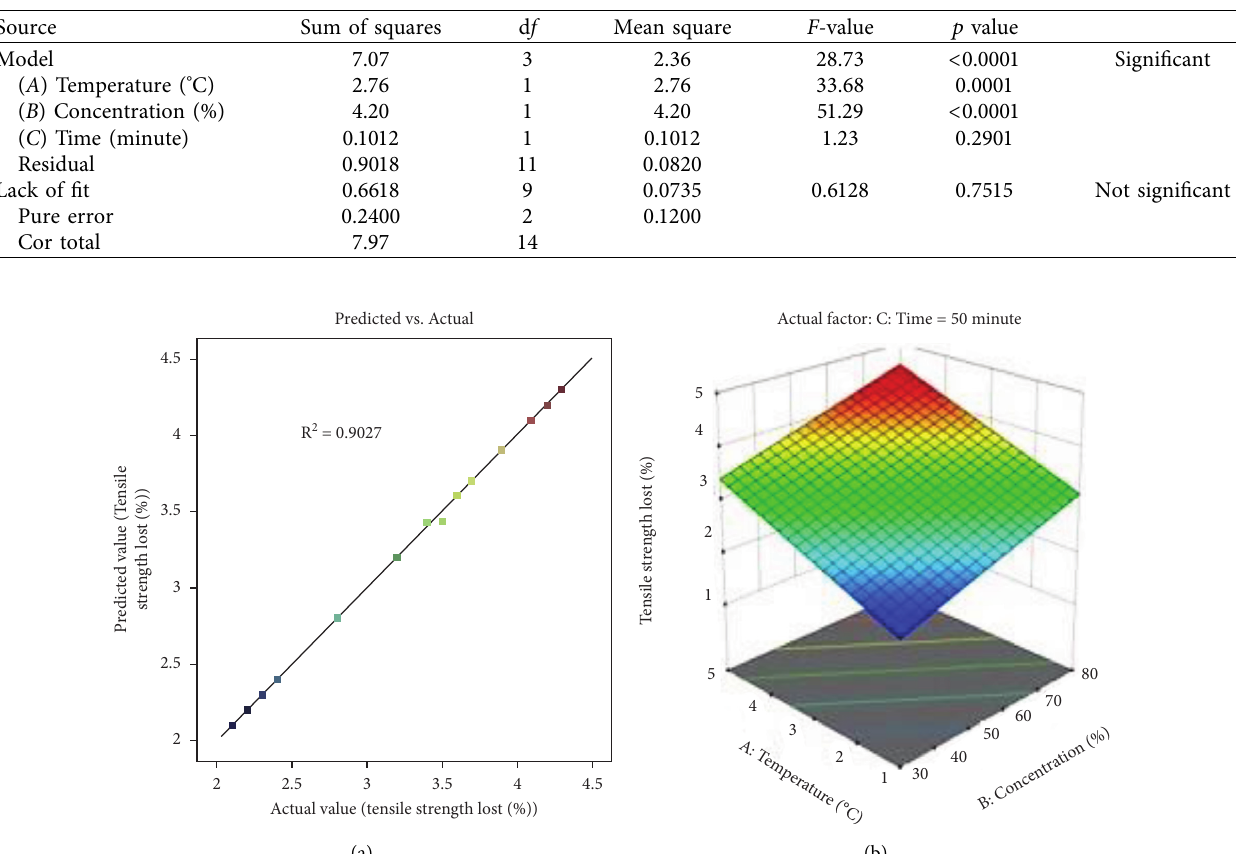
Table 4: Analysis of variance (ANOVA) for tensile strength of the enzyme-treated dyed fabric.